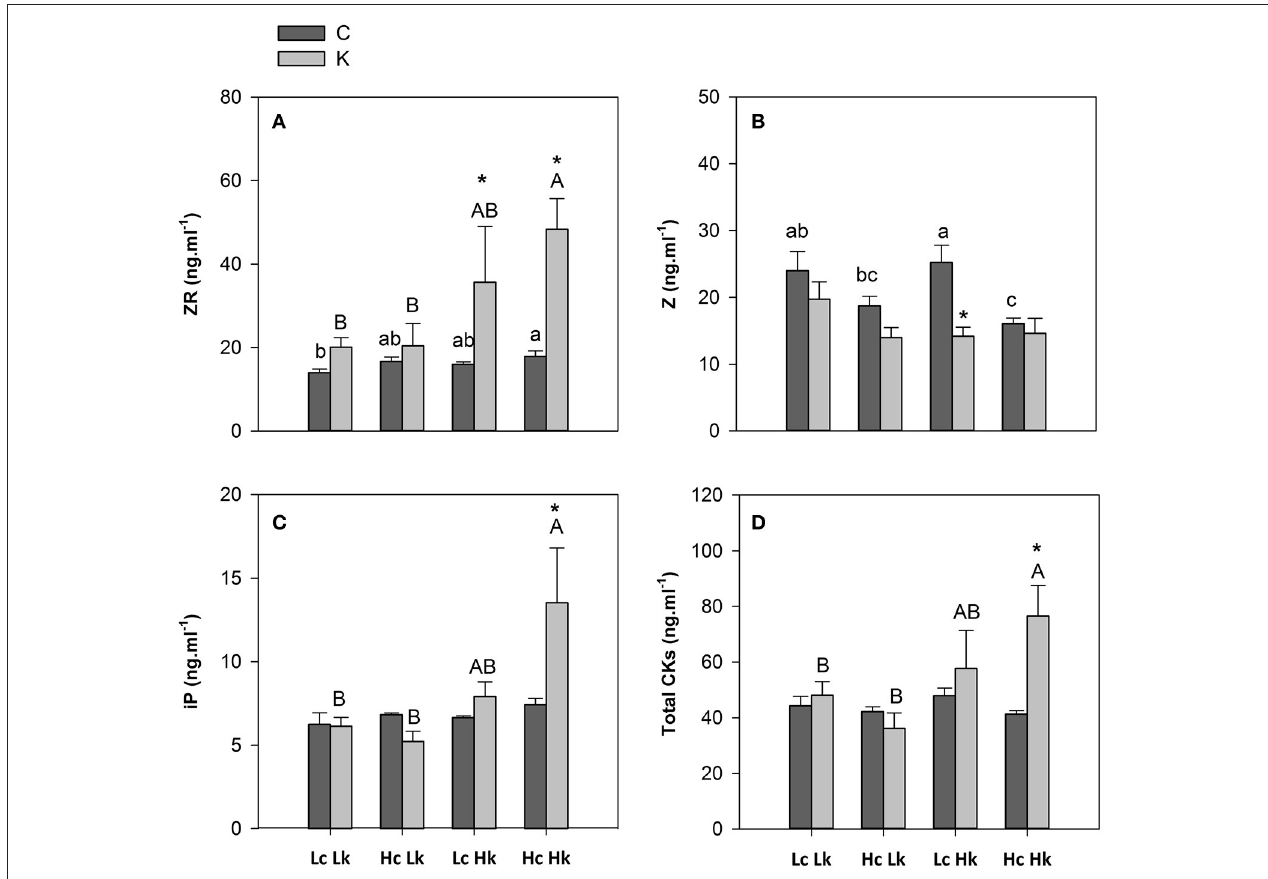
FIGURE 4 | Zeatin riboside, ZR (A), zeatin, Z (B) , isopentenyl adenine, iP (C) and total cytokinins, CKs (D) concentrations in root xylem sap of the scion ( Solanum lycopersicum cv. Boludo F1) grafted onto a population of recombinant inbred lines (RILs) from a cross between Solanum lycopersicum × Solanum pimpinellifolium with high ( H ) or low ( L ) vigor growing under control ( c ) and low K ( k ) conditions during 48 days. Different letters indicate significant differences among graft combinations ( n = 12, P < 0.05) within each treatment. * indicate significant differences between control and low-K treated plants according to the Tuckey test ( P < 0.05).